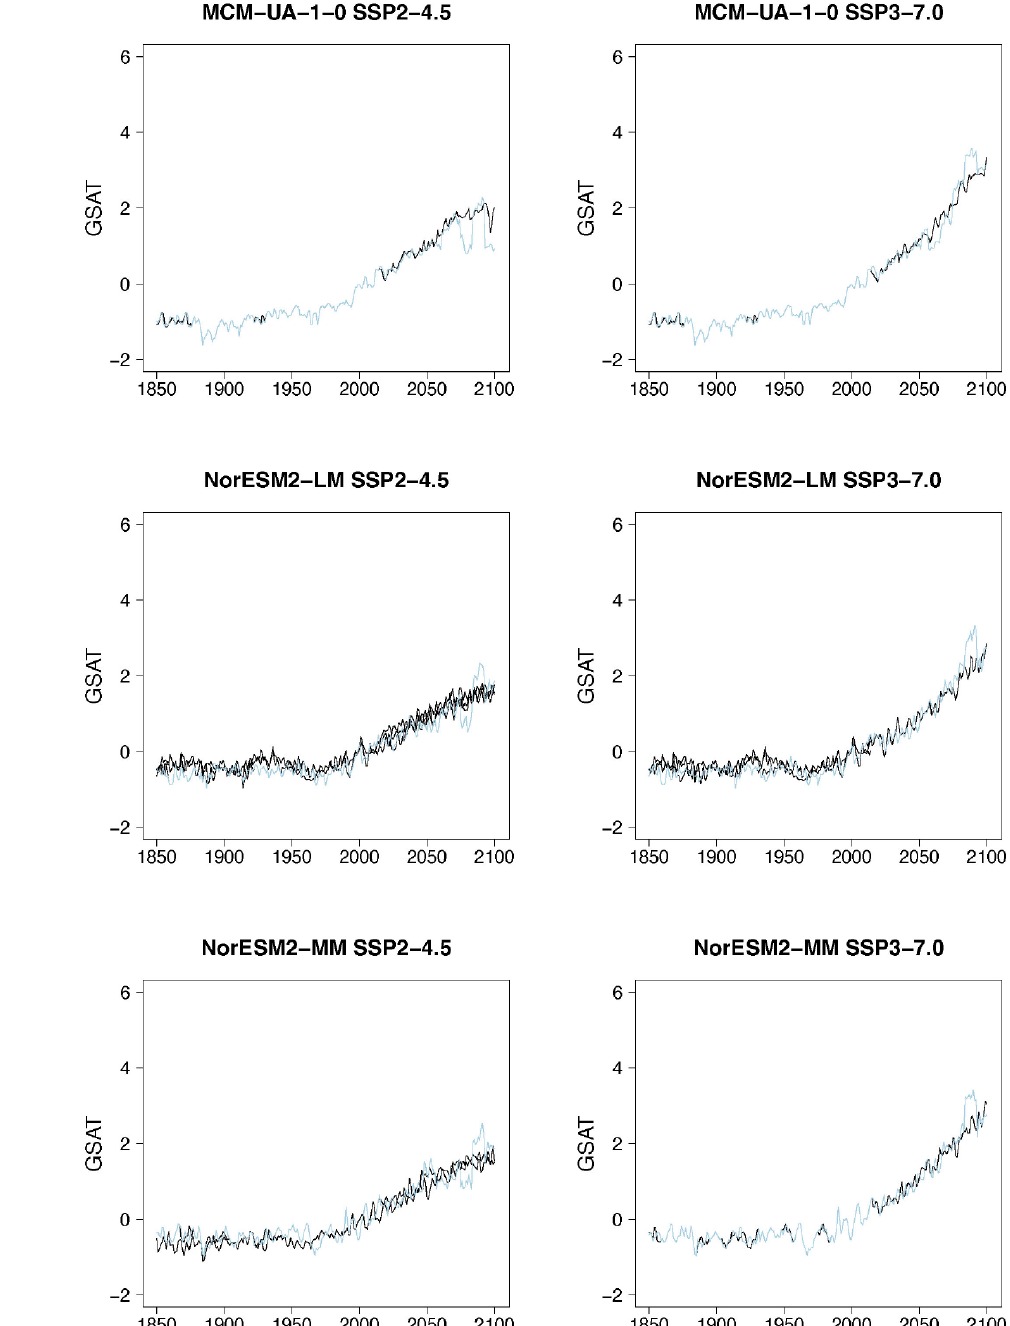
Figure B6. Examples of target (black lines) and stitched (colored) GSAT time series for ESMs in the PANGEO archive that ran at least one trajectory along the Tier 1 experiments of ScenarioMIP (SSP1-2.6, SSP2-4.5, SSP3-7.0, SSP5-8.5). We use the two bracketing scenarios and emulate trajectories that follow the two intermediate